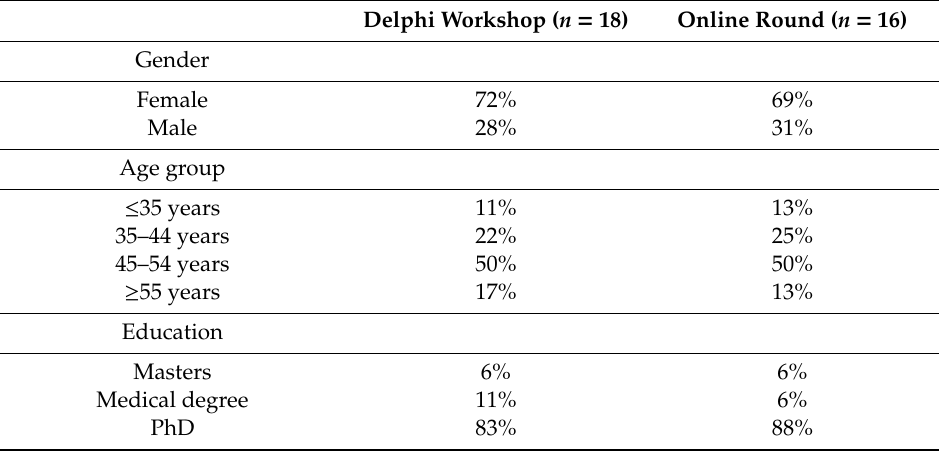
Table 2. Characteristics of experts who completed the Delphi workshop and the online